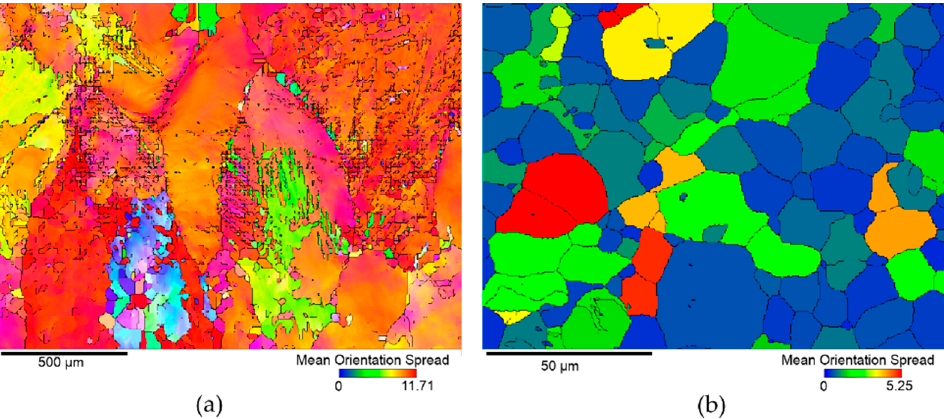
Figure 10. Grain orientation spread (GOS) maps of ( a ) rolled and ( b ) extruded sample. The presence of dislocations in crystals leads to a decrease in the Young’s modulus, i.e., a quasi-static modulus defect may be observed, which in the low-frequency limit is deter- mined by the dislocation density Λ and the average length L c of dislocation segments [14]: